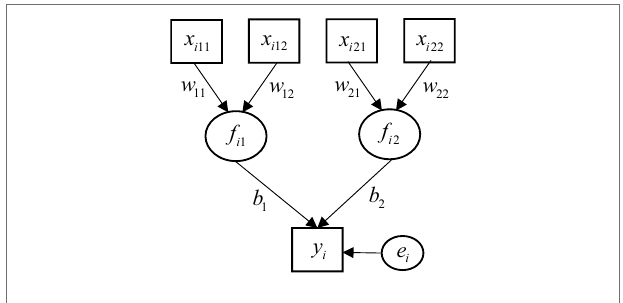
FIGURE 1 | A prototypical ERA model. Square boxes indicate observed predictor and response variables. Circles represent components and an error